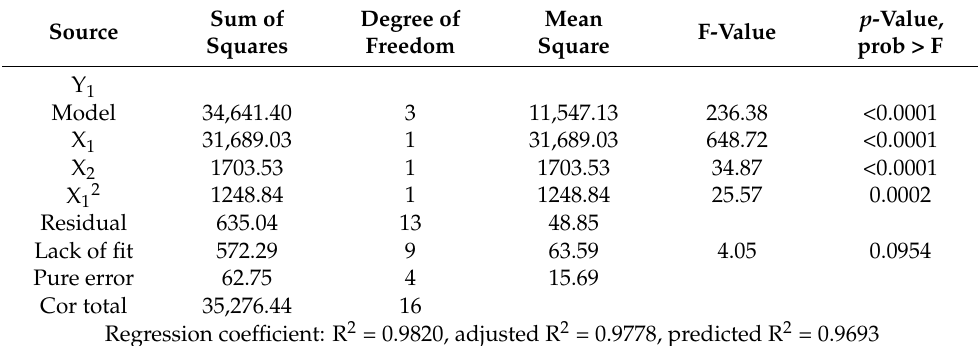
Table 4. ANOVA results of the fitted model for predicting Y 1 .